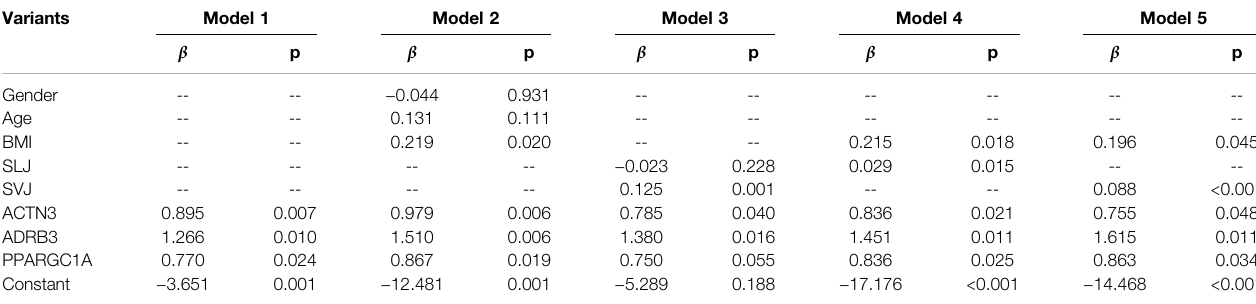
TABLE 3 | Multivariate logistic regression analysis for power